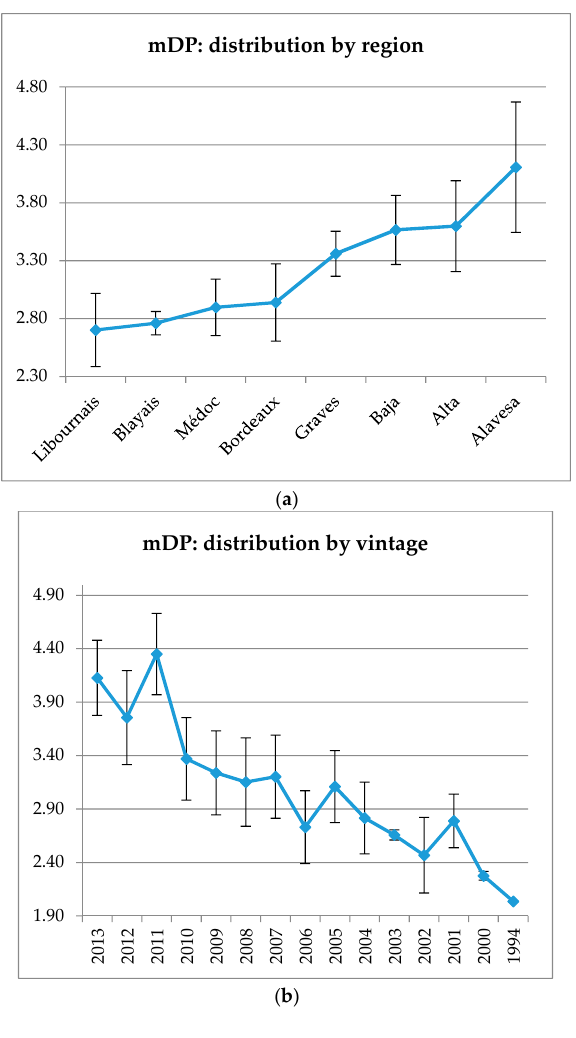
Figure A2. Mean degree of polymerization distributed by region ( a ) and vintage ( b ). Error bars are standard deviation of wine samples within each category.